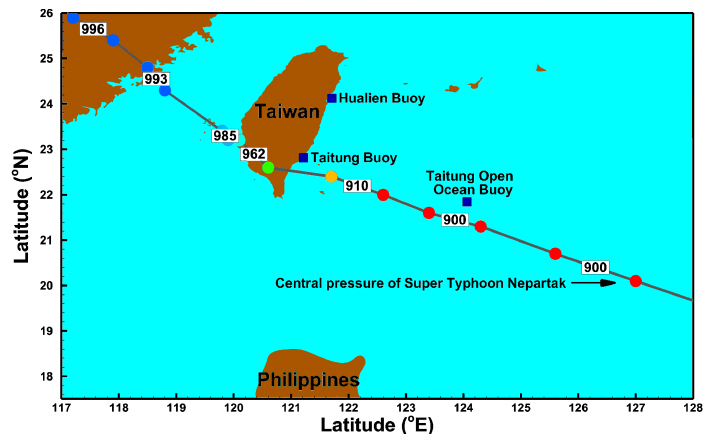
Figure 2. Track and central air pressures of Super Typhoon Nepartak in 2016 and the locations of wave buoys. The color of the solid circles represents the typhoon intensity as classified on the Sa ffi r–Simpson scale (red: category 5; yellow: category 4; green: category 3; cyan: category 2; blue: category 1).